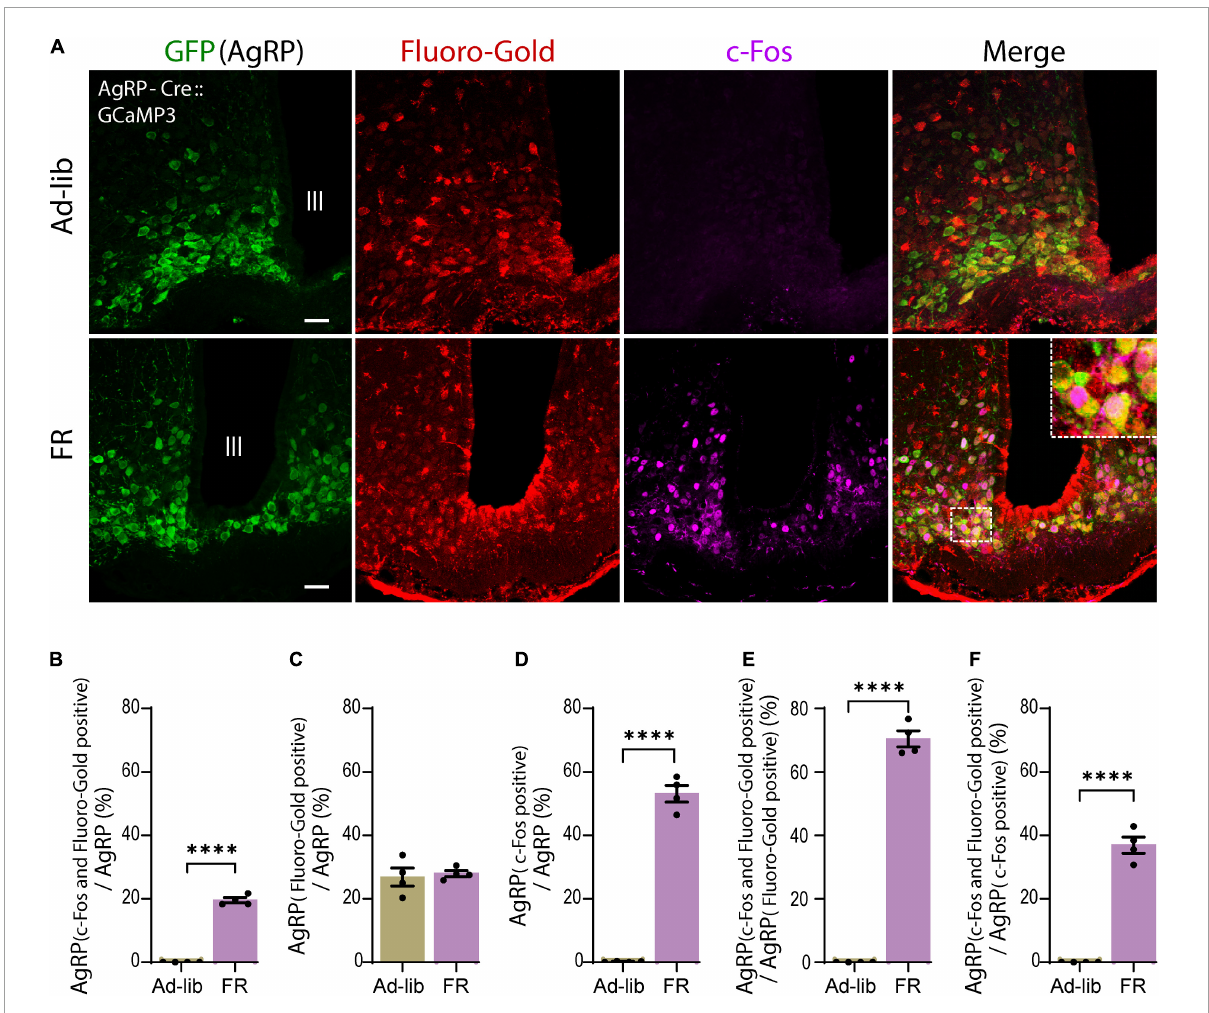
FIGURE4 A subset of agouti-related peptide (AgRP) neurons directly projecting to the median eminence were activated by food restriction (FR). (A) Triple immunostaining of arcuate nucleus (ARC) with anti-GFP for AgRP (green), anti-Fluoro-Gold (red), and anti-c-Fos (magenta) antibodies in ad libitum (Ad-lib) (upper panel) and FR (lower panel) conditions. Note that no c-Fos signals were observed in Ad-lib group. The dotted boxed area indicates higher magnifications image ( × 4). Scale bars, 40 µ m. (B) A subset of AgRP neurons (19.49% ± 0.82%) co-express both Fluoro-Gold and c-Fos under FR. (C) In the FR, 27.72% ± 0.95% of AgRP neurons were labeled by Fluoro-Gold, while comparable proportion of AgRP neurons (26.76% ± 2.73%) were labeled by Fluoro-Gold in Ad-lib group ( P = 0.737; unpaired Student’s t test). (D) 53.43% ± 3% AgRP neurons were c-Fos positive in FR group. (E) 70.38% ± 2.54% of Fluro-Gold-positive AgRP neurons were also positive for c-Fos in FR group. (F) 36.84% ± 2.58% of c-Fos-positive AgRP neurons were Fluoro-Gold positive. **** P < 0.0001; unpaired Student’s t test. Error bars represent